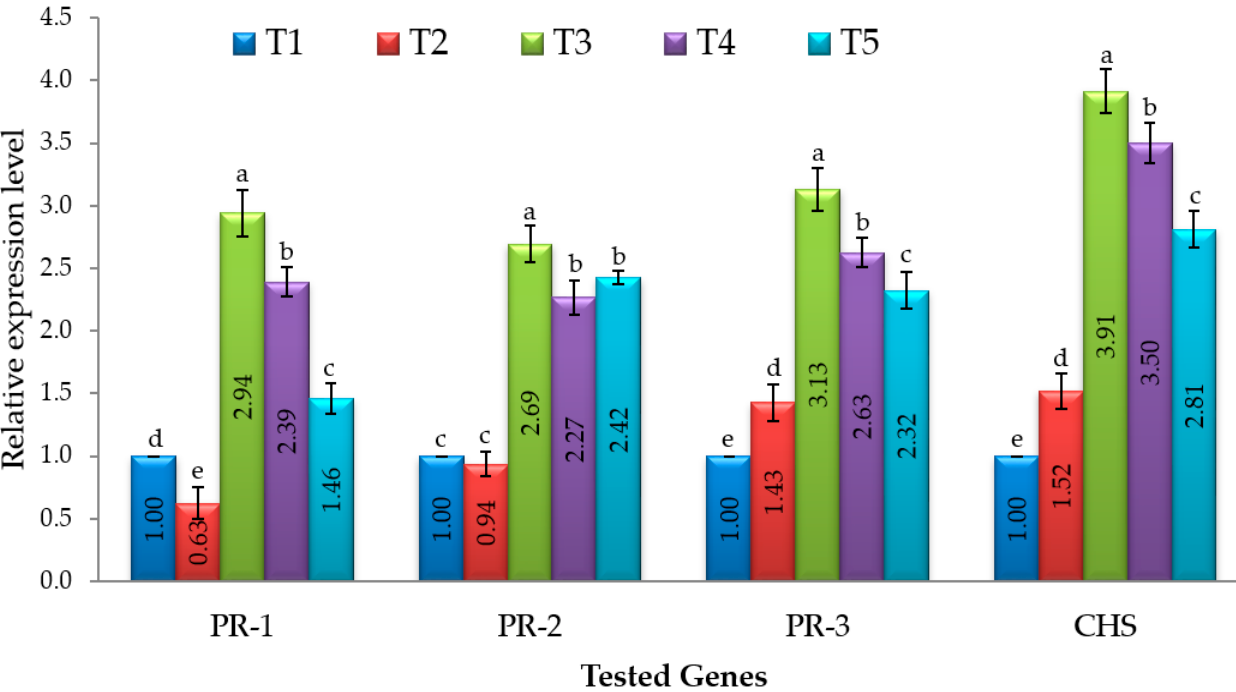
Figure 7. A histogram shows the relative expression levels of the PR-1, PR-2, PR-3, and CHS genes at 20 dpi in the assay of different treatments. T1: tomato plant control inoculated with media-free microorganisms; T2: tomato plants inoculated with R. solani only; T3: tomato plants inoculated with T. asperelloides ; T4: tomato plants inoculated with T. asperelloides 48 h before inoculation with R. solani (protective application); T5: tomato plants inoculated with T. asperelloides 48 h after inoculation with R. solani (curative application) . Data with the same letters are not significantly different at p ≤